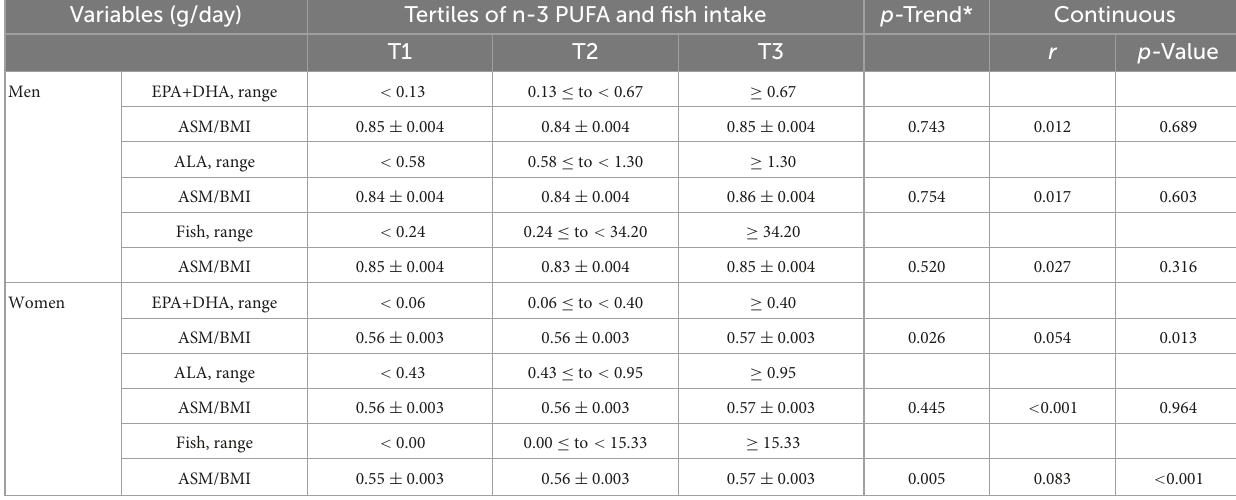
TABLE 3 Correlation between muscle mass and n-3 PUFA and fish intake in men and women. Variables (g/day) Tertiles of n-3 PUFA and fish intake p -Trend* Continuous T1 r p